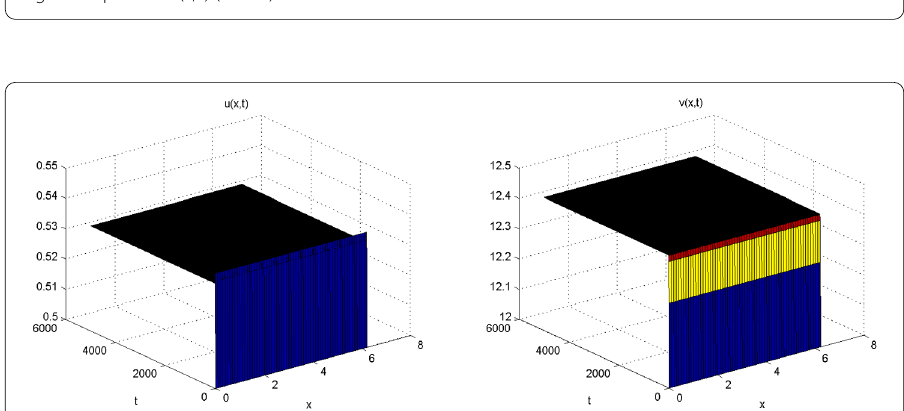
Figure 4 For system (4.2), τ = 0 and the initial condition is (0.5,12). Left component: u ( x , t ) (Stable). Right component: v ( x , t ) (Stable).